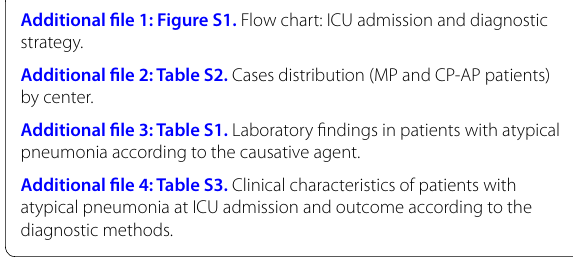
Additional file 1: Figure S1. Flow chart: ICU admission and diagnostic strategy. Additional file 2: Table S2. Cases distribution (MP and CP-AP patients) by center. Additional file 3: Table S1. Laboratory findings in patients with atypical pneumonia according to the causative agent. Additional file 4: Table S3. Clinical characteristics of patients with atypical pneumonia at ICU admission and outcome according to the diagnostic methods.